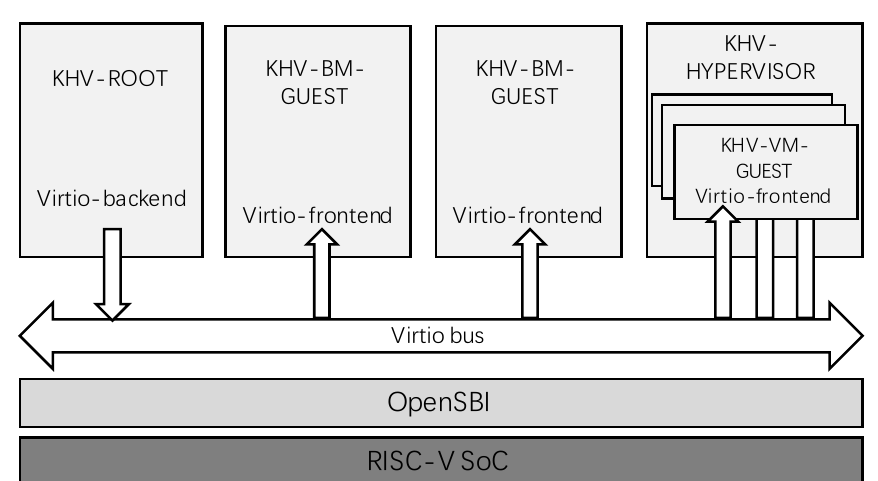
Figure 2. KHV on SoC.